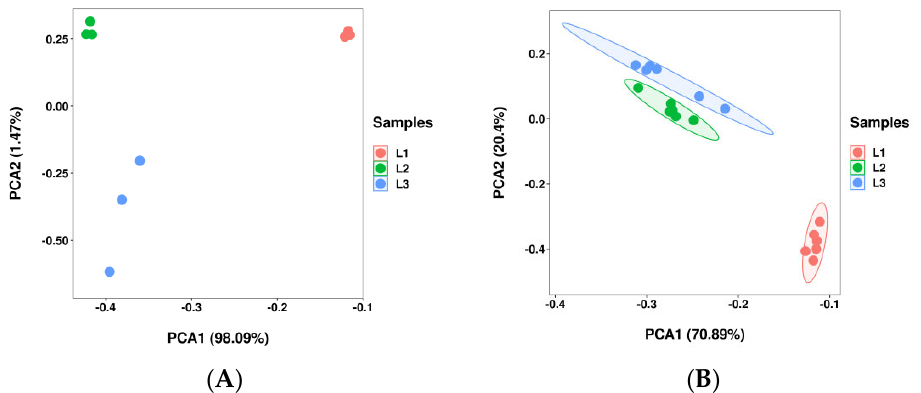
Figure 2. Principal component analyses (PCAs) of transcripts and metabolites during walnut fruit development. Note: ( A ) PCA score of transcriptomic data and ( B ) PCA score of metabolomic data. The x -axis represents principal component 1 (PC1); the y -axis represents principal component 2 (PC2). The three time points are distinguished by different colors. L1 was 60, L2 was 90, and L3 was 120 DAP.